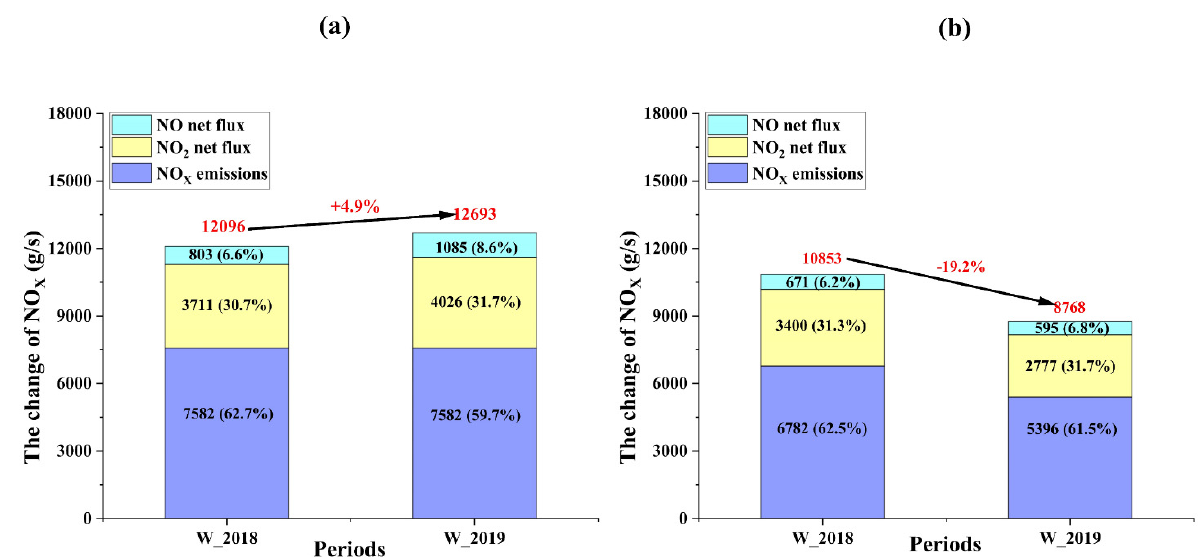
Figure 7. Variations in NO X emissions, city boundary transport fluxes, and their relative contributions in BJ. ( a ) Simulated with MEIC-2017 inventory. ( b ) Simulated with top-down NO X inventory.